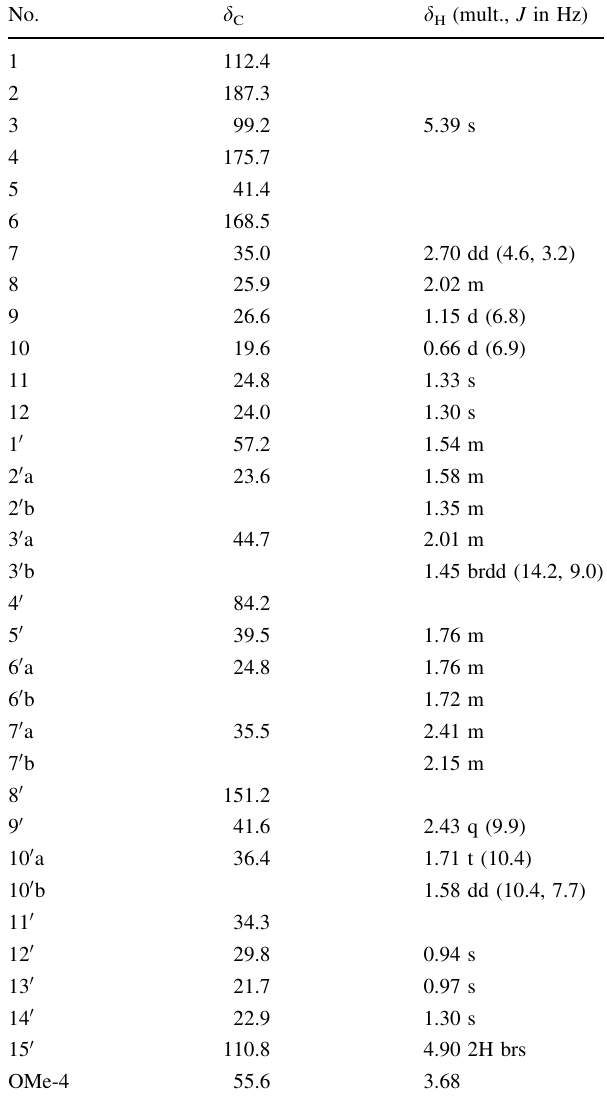
Table 4 1 H (500 MHz) and 13 C (125 MHz) NMR data of 7 in CDCl 3